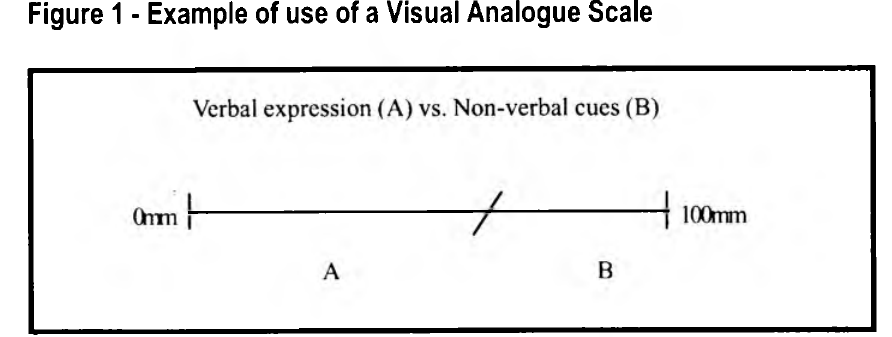
the Delphi technique about 30 to 45